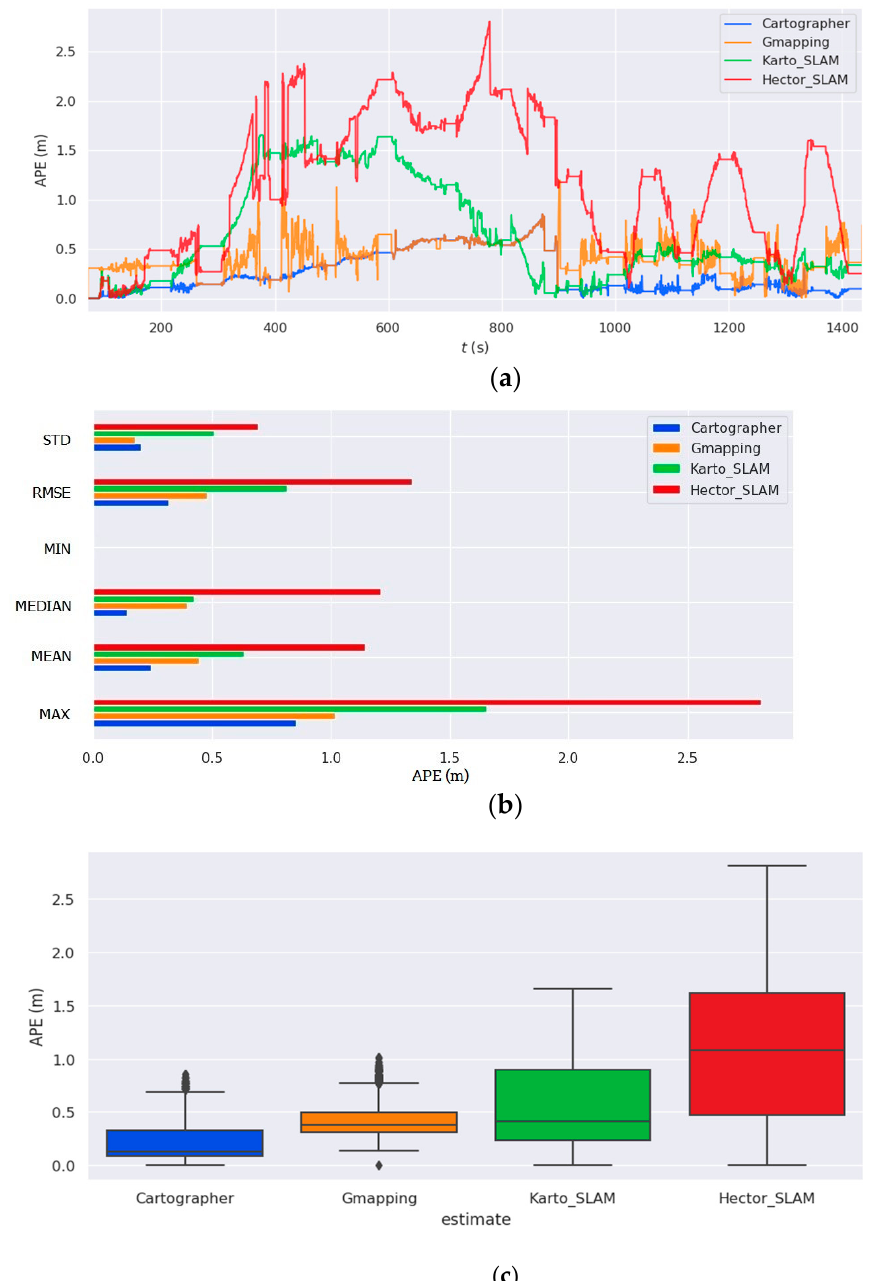
Figure 9. Comparison of absolute positional errors between multiple SLAM systems: ( a ) the graph of absolute pose errors of four SLAM methods, ( b ) statistic errors of four SLAM methods, and ( c ) box plots of four SLAM methods.